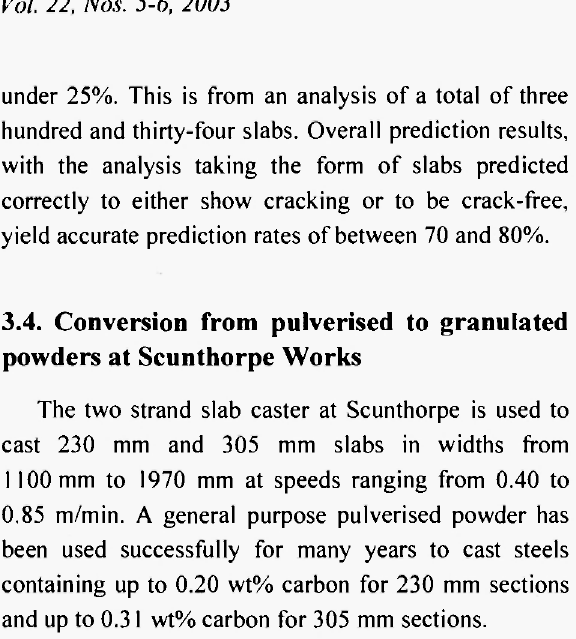
Fig. 10: STA results for granulated and pulverised